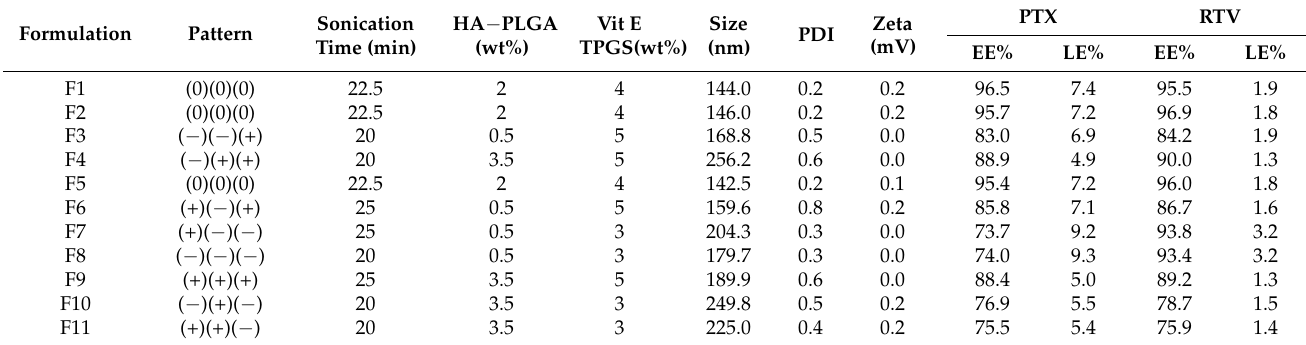
Table 2. Full factorial design of experiment using JMP